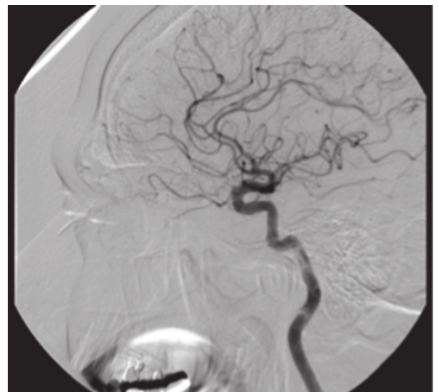
Figure 3: Ethmoid vascularization by branches from the left oph- thalmic